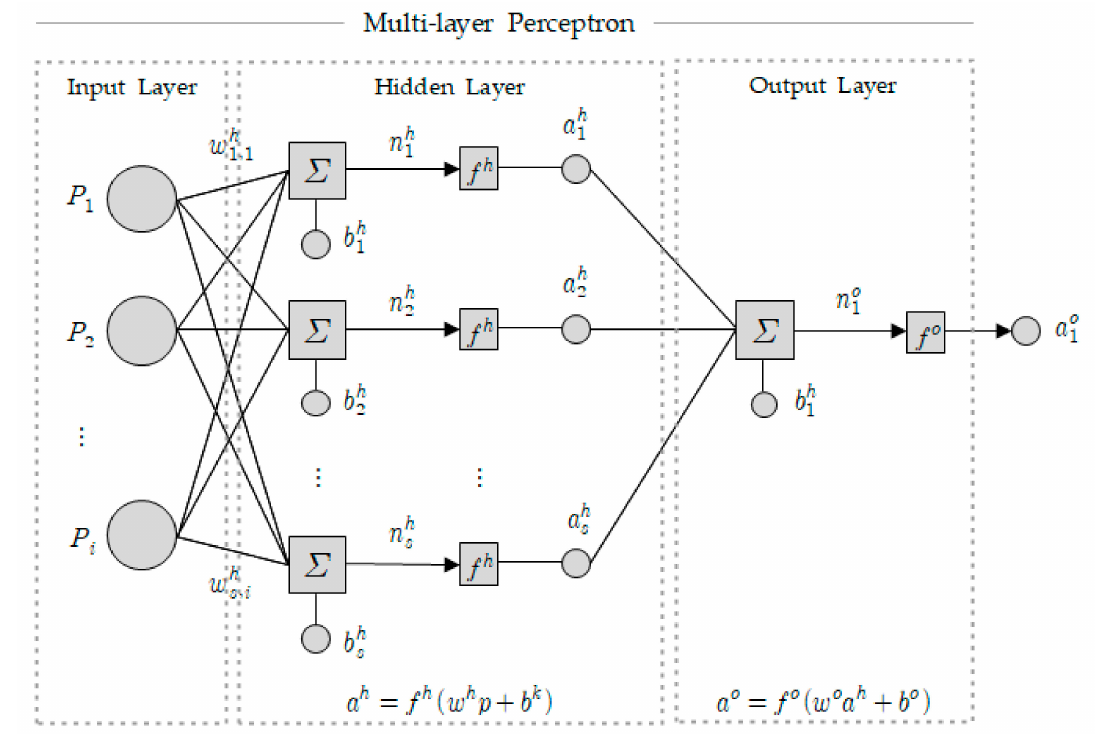
Figure 4. Artificial neural network (ANN) model